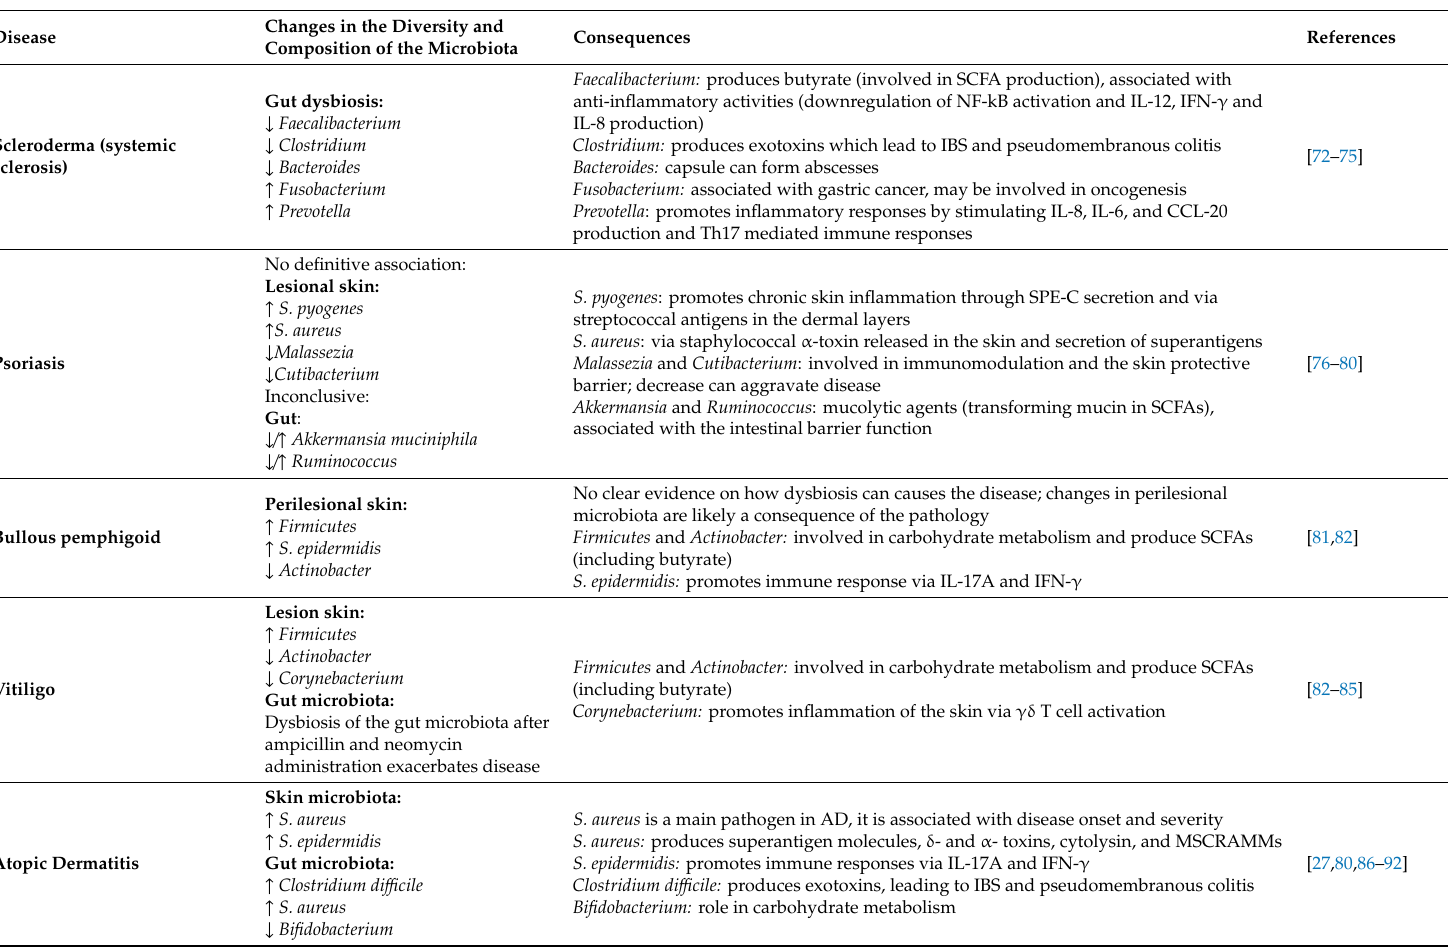
Table 2. The link between several autoimmune skin diseases and changes of